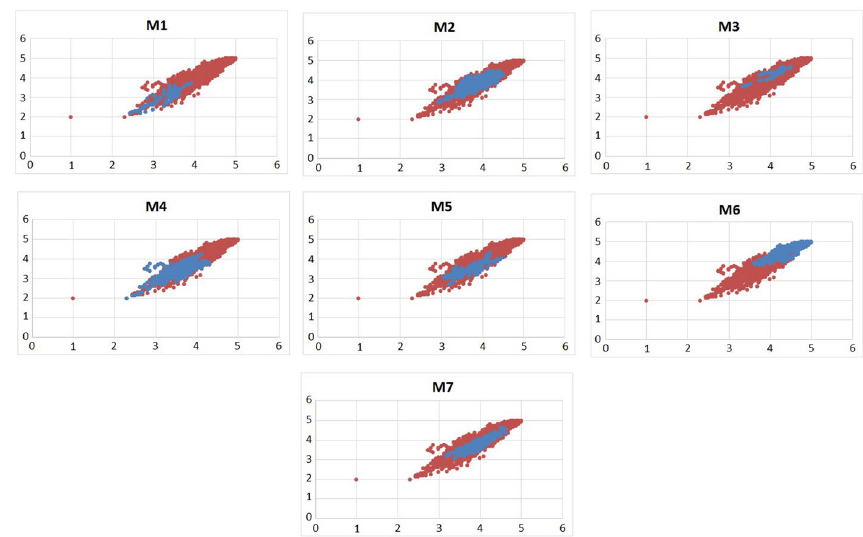
Fig. 8 The correlation between “absolute quality” and “relative quality” from the user point of view for some messenger applications based on the IR-QUMA data. Every point represents average values of one data